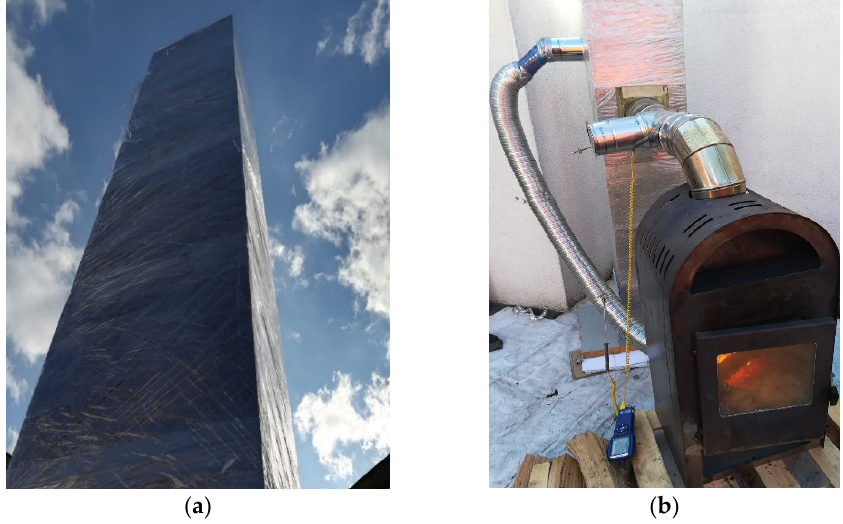
Figure 4. Test photos: ( a ) view of sealed chimney over the roof and ( b ) heating appliance after installation.